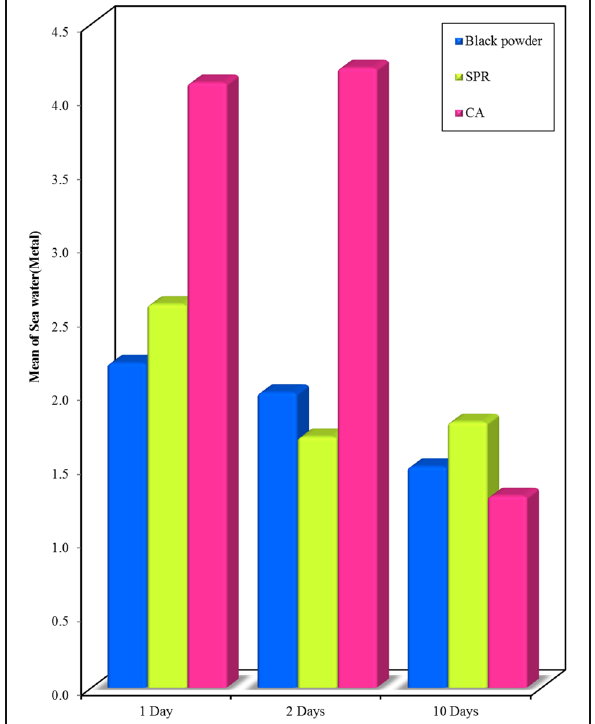
Fig. 7 Bar graph - Comparison between the Black powder, SPR and CA development techniques at different time intervals (1, 2, and 10 days) on metal surface recovered from sea water . It shows higher mean visibility score after using CA in 1 and 2 day ’ s